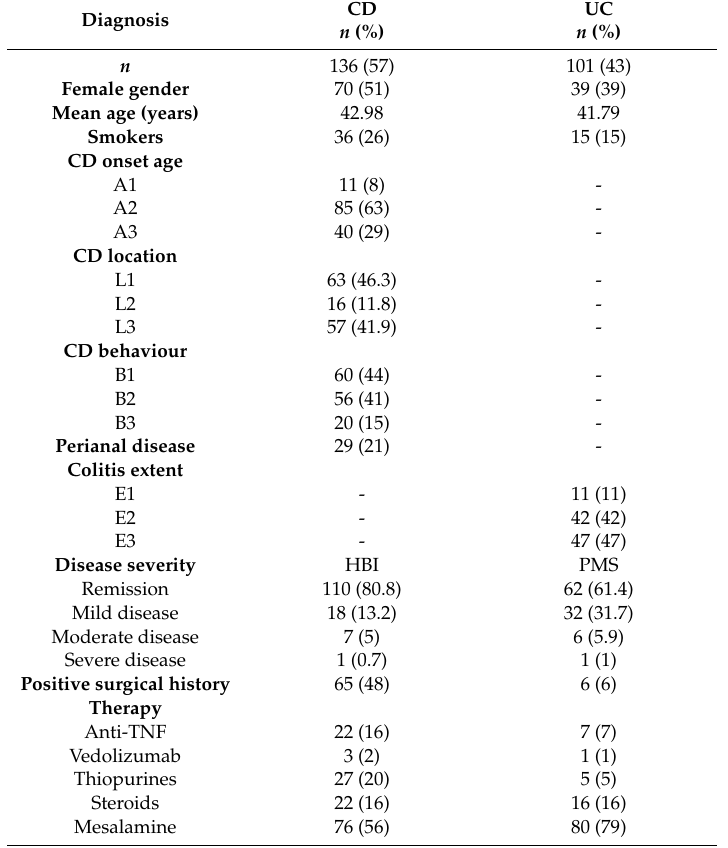
Table 1. Demographic and clinical characteristics of the 237 enrolled